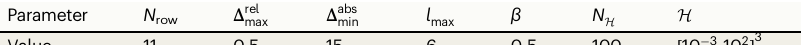
Table 1 | Default parameter values used for the fi nal algorithm Parameter